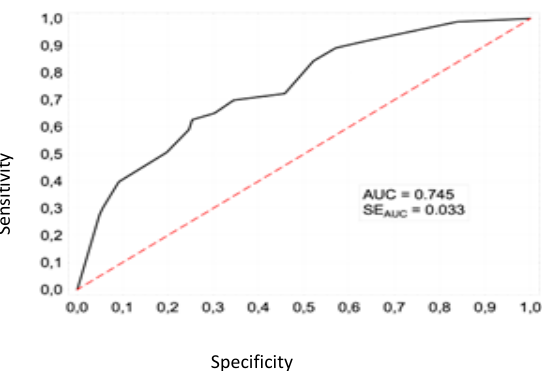
Table 4. Results of the logistic regression analysis of the risk of death.